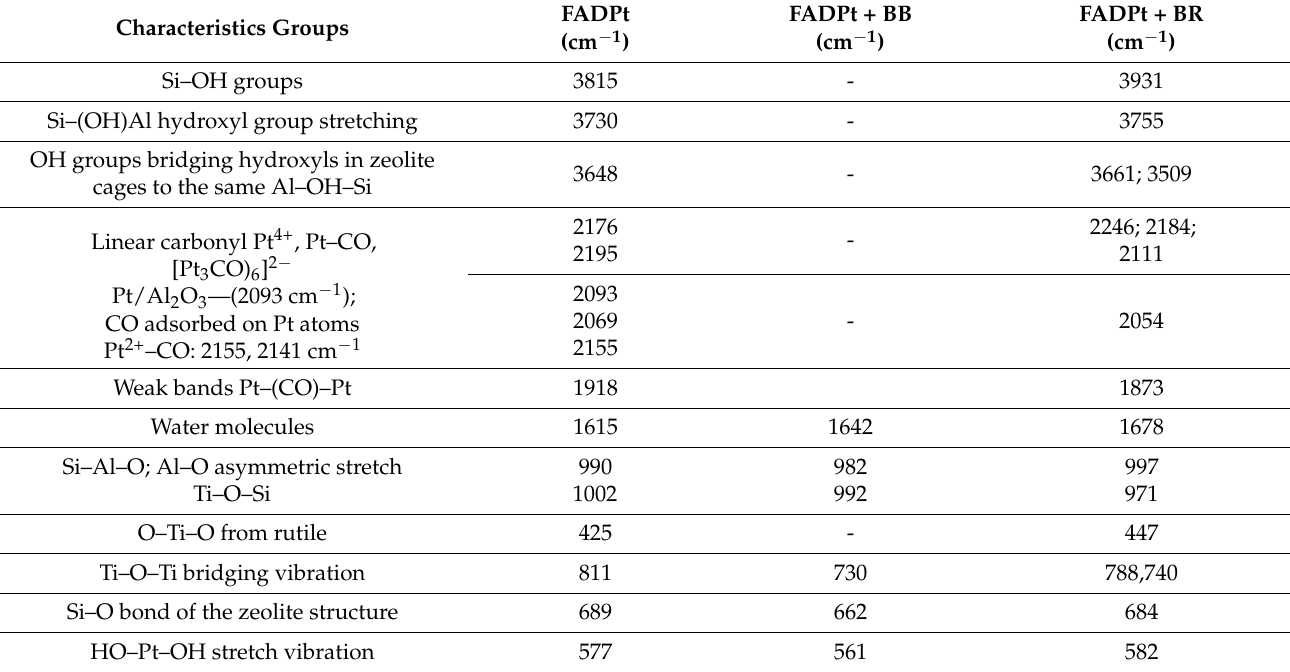
Table 6. Characteristics of IR bands associated with FADPt, FADPt with loaded BB and FADPt with loaded BR. Characteristics